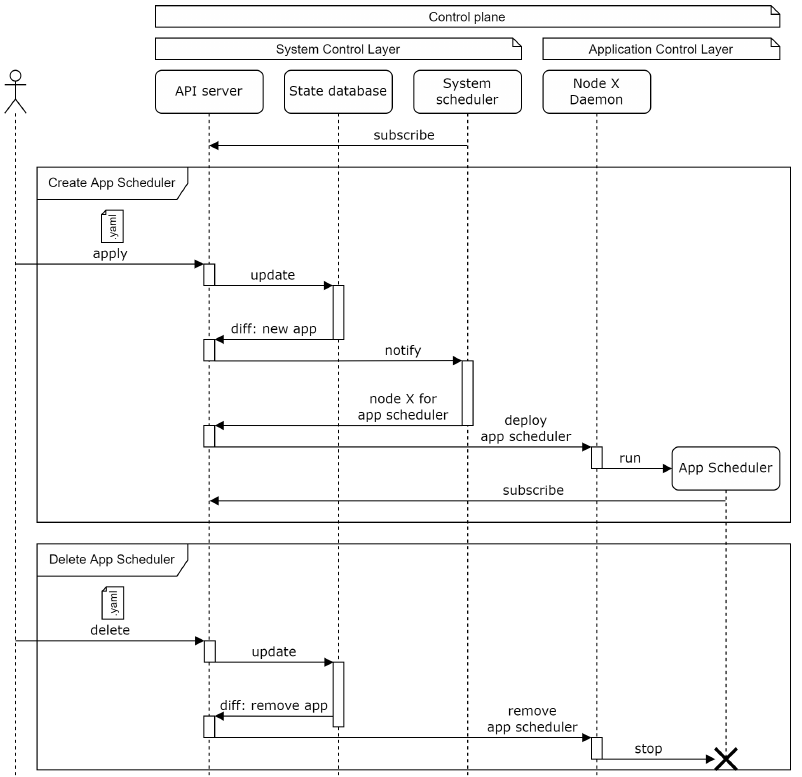
Figure 4. UML sequence diagram for applications’ schedulers deployment.